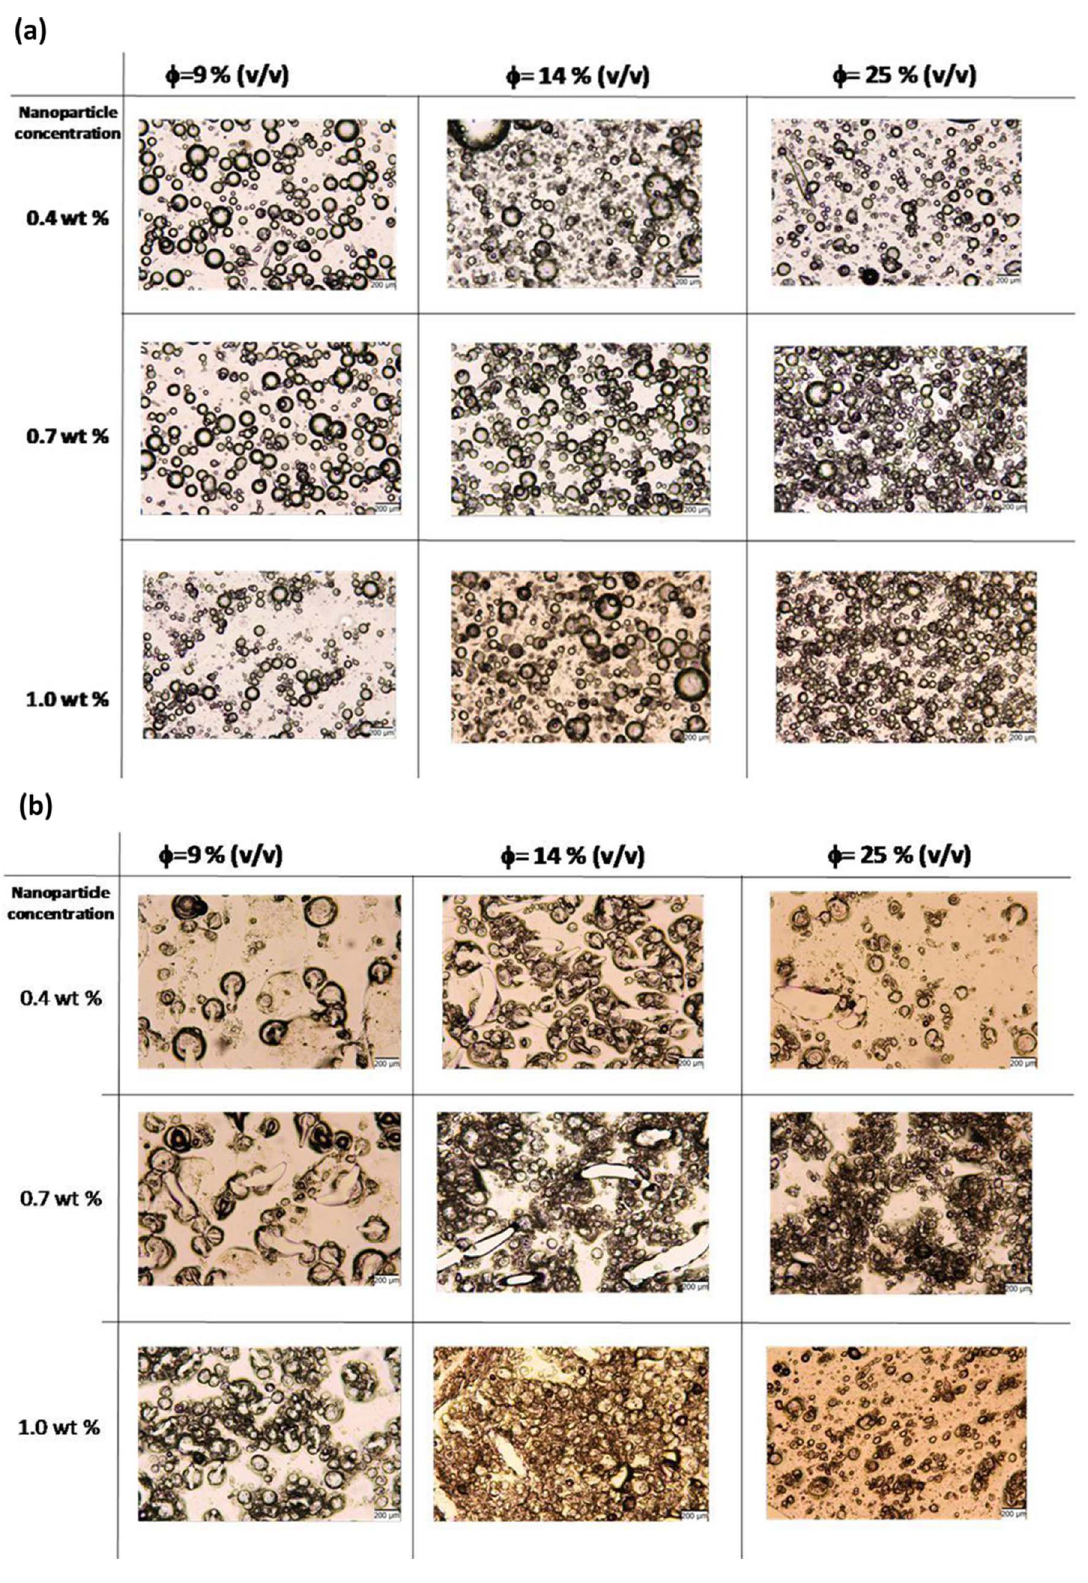
Figure 3. Optical microscope images of emulsions for altered concentrations of nanoparticles and internal phase volume fractions. Internal phase does not contain agarose gel. (a) Wet and, (b) dry emulsions. Scale bar represents 200 m m.